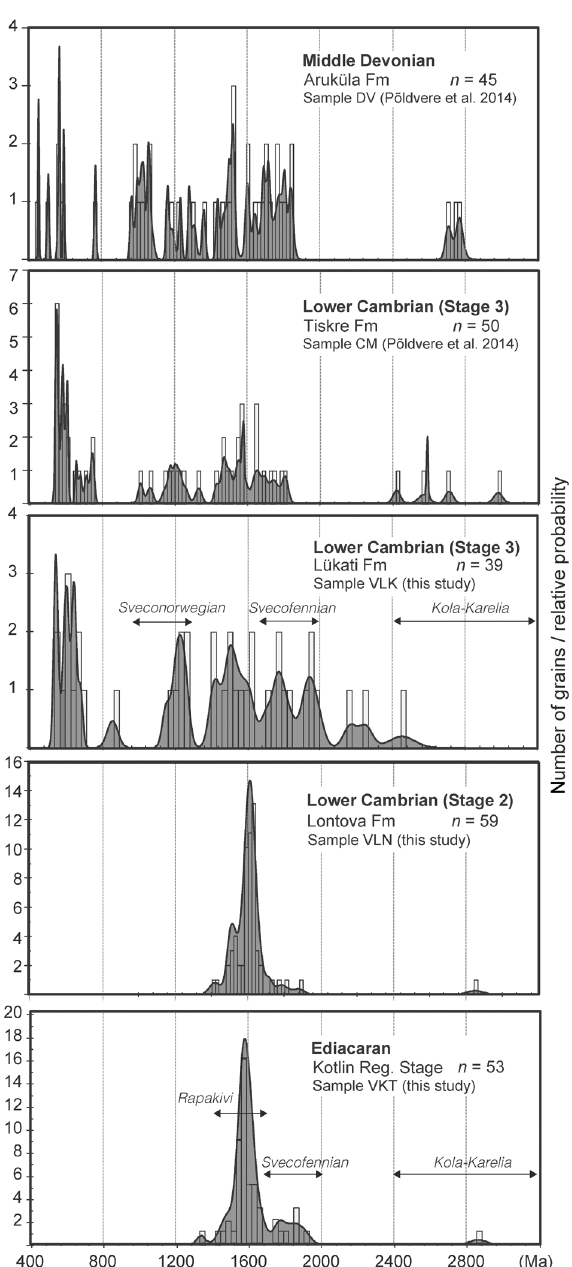
Fig. 2. U(cid:150)Pb age spectra (in the histogram and in the probability age frequency curve) of detrital zircon grains from the Ediacaran Kotlin Regional Stage (VKT), Lower Cambrian (Stage 2) Lontova and L(cid:252)kati formations (VLN, VLK) of the Velise-F97 drilled core from central Estonia, demon- strated together with those of the Lower Cambrian (Stage 3) Tiskre Formation (CM) and the Middle Devonian Aruk(cid:252)la Formation (DV) (Pıldvere et al. 2014) for comparison. Refer to http://dx.doi.org/10.15152/GEO.5 for measurement tables (DD-Tables 1(cid:150)3) and Concordia diagrams (DD-Figs 1(cid:150)3). One time bin for histogram is 20 million